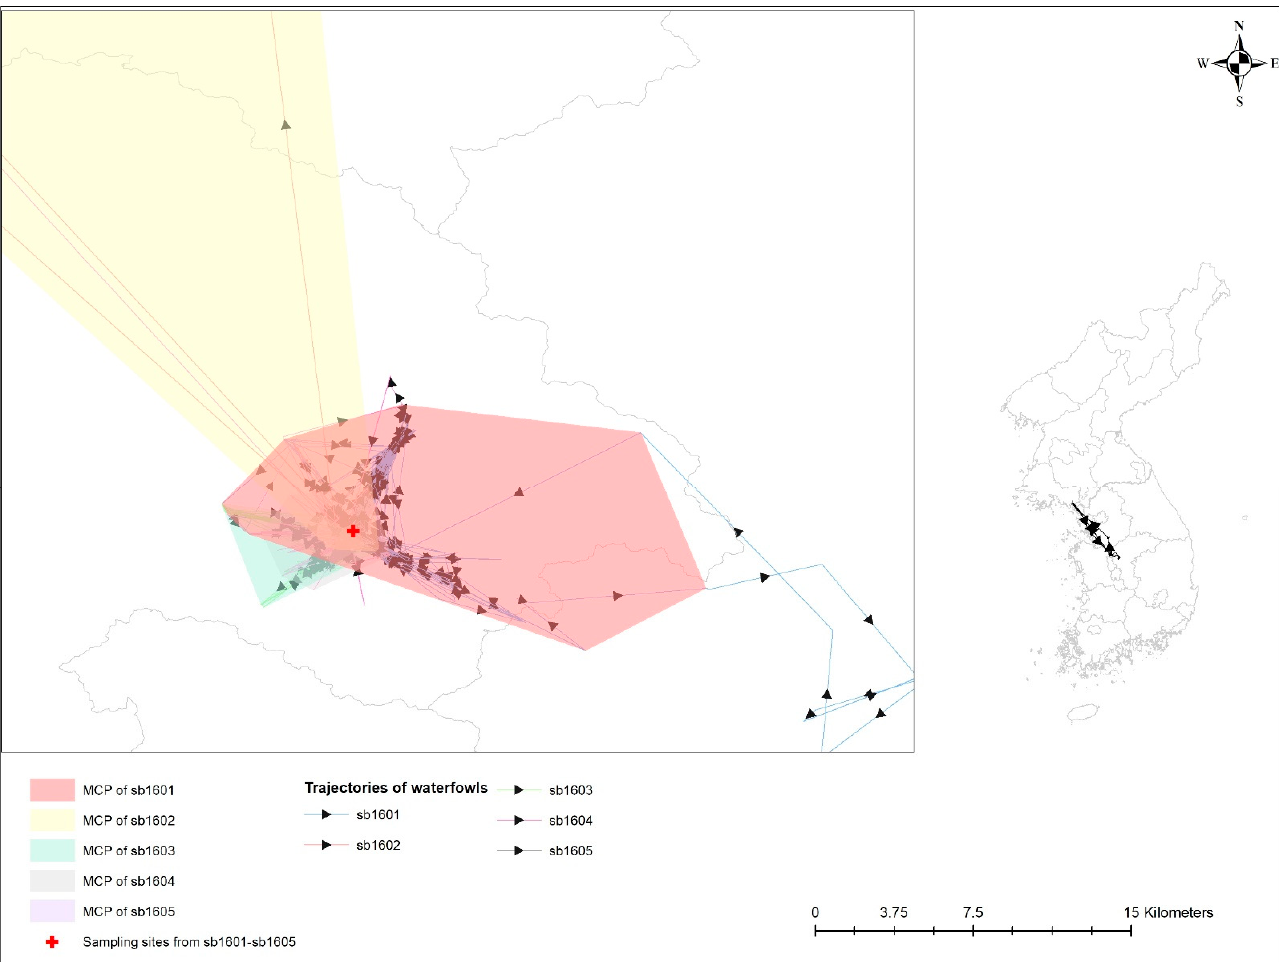
Figure 3. Trajectories and minimum convex polygon (MCP) of five waterfowls with avian influenza infection. Different colors represent 99% MCP of individual waterfowl; bright red for sb1601; bright yellow for sb1602; bright green for sb1603; grey for sb1604; and bright purple for sb1605. Sampling sites for avian influenza antigen and antibody from those birds are denoted by a red cross.